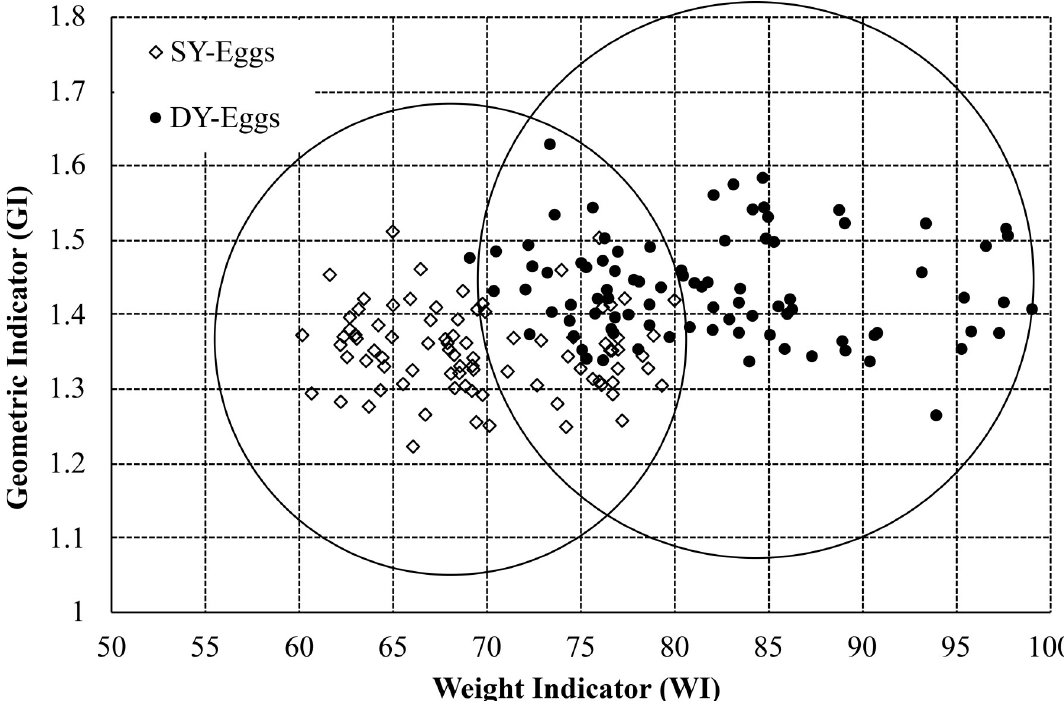
Fig 2. Relationship between the geometry indicator and weight indicator. The group was classified into two clusters. The left cluster was clearly classified that there was a SY egg cluster. The right cluster was clearly classified as a DY egg cluster. The intersection area was a sample with a fuzzy member that could not be clearly identified as DY eggs or SY